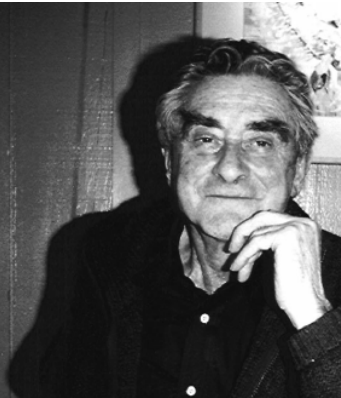
Figure 2. Charles Abraham Rosen, 7 December 1917–8 December 2002 [10].